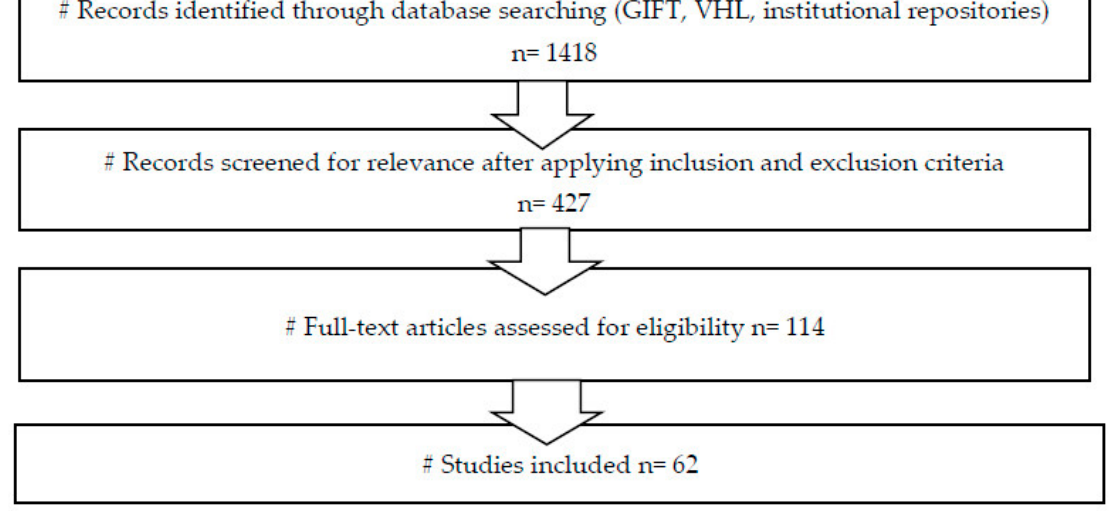
Figure 1. Flow diagram of evidence selection from primary studies.